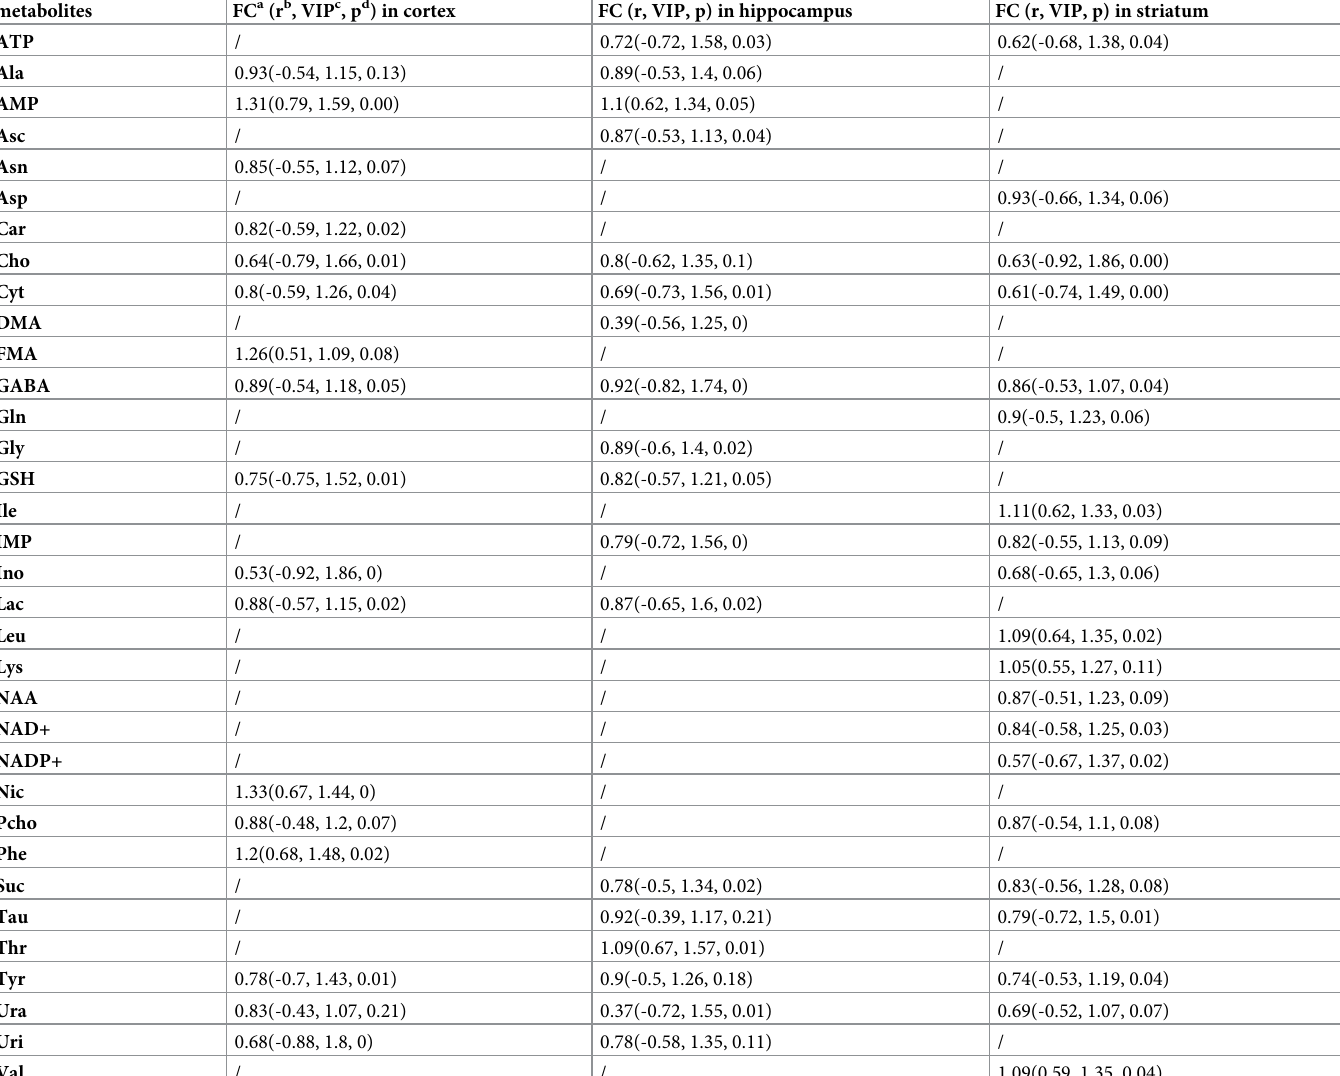
Table 2. Summary of a panel of discriminant metabolites identified to be significantly changed between heliox saturation-hyperbaric-exposed and control rats in the three brain regions of cerebral cortex tissues, hippocampus, and striatum. metabolites